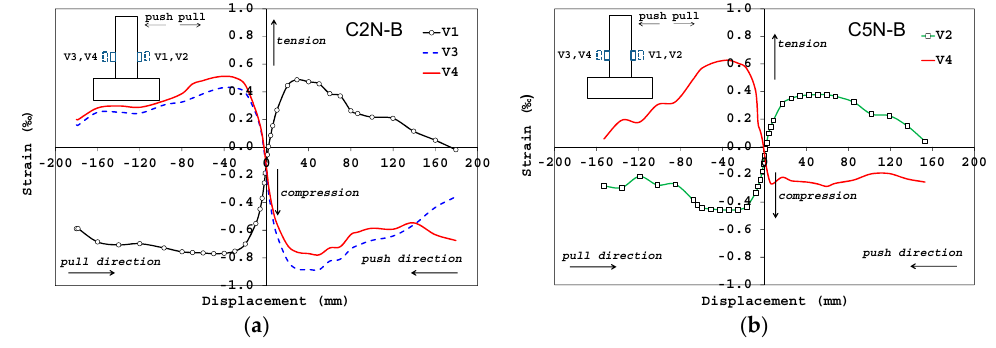
Figure 21. Strains on the L-shape steel profiles: tests C2N-B ( a ) and C5N-B ( b ).